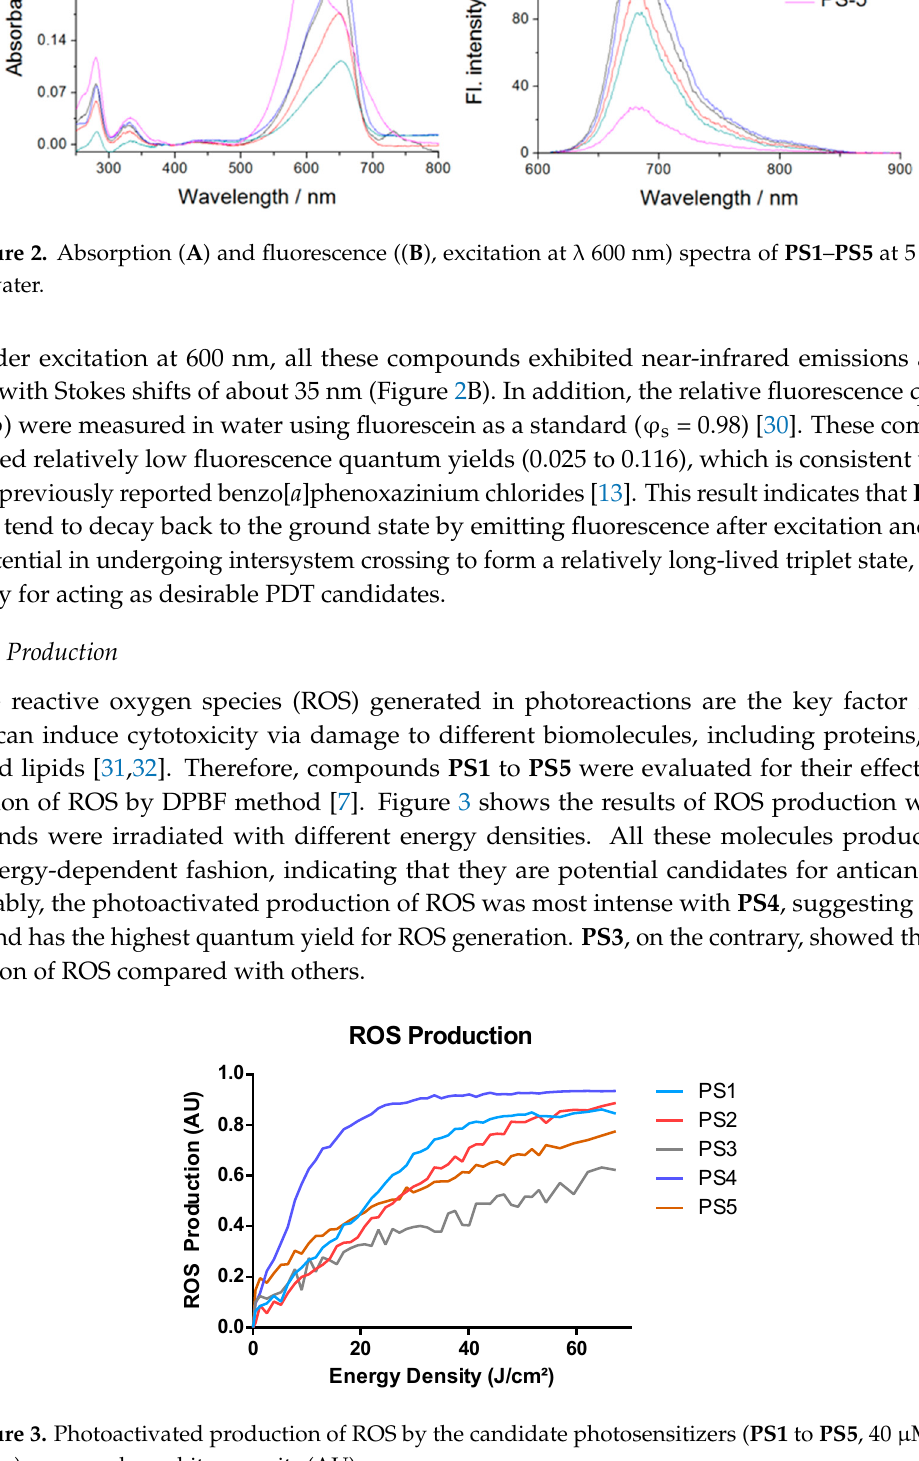
Table 1. Absorption and emission data of benzo[ a ]phenoxazinium chlorides PS1 - PS5 in water. Compound